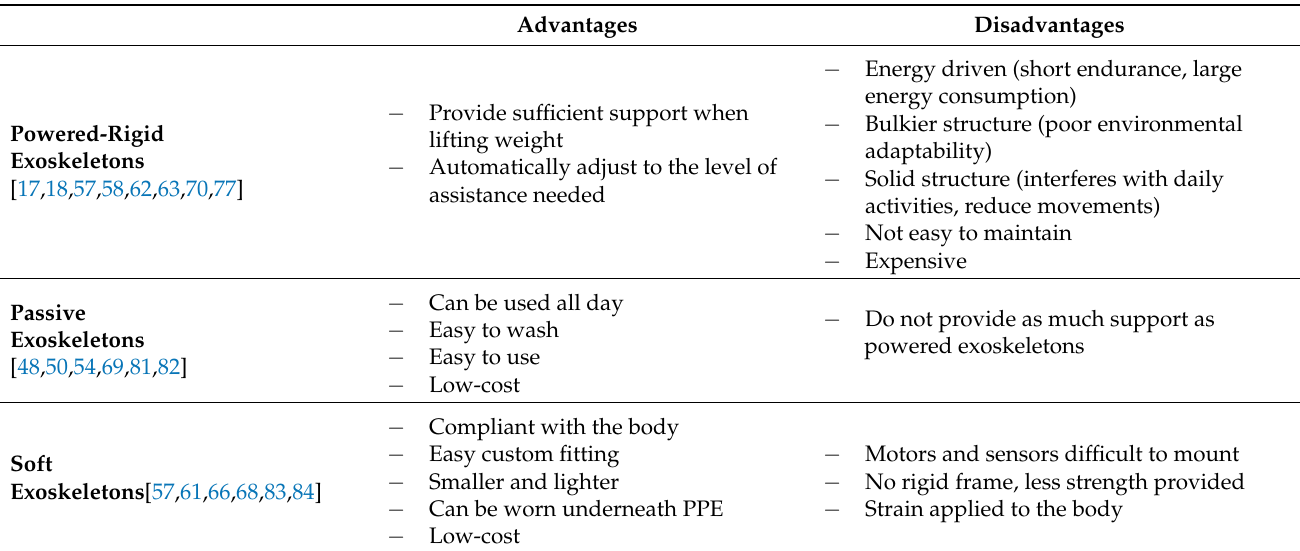
Table 3. Advantages and Disadvantages of Powered-Rigid, Passive and Soft